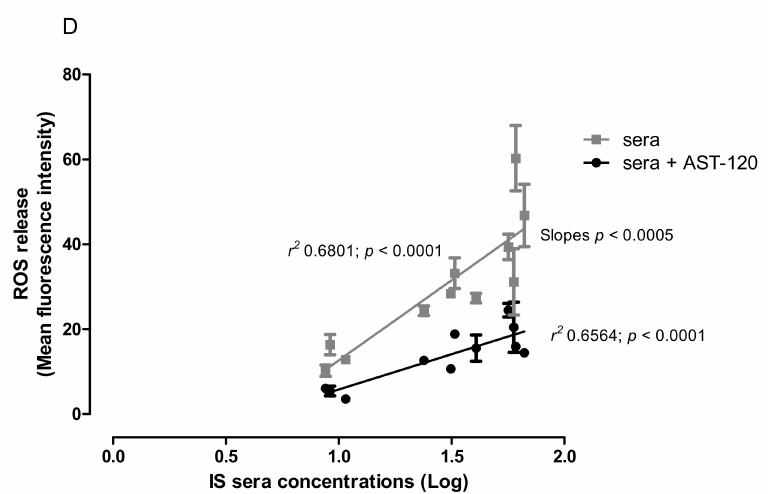
Figure 7. E ff ect on ROS formation of sera from eleven subjects: sera from three human healthy people (H1, H2, H3; Panel A ), sera from four CKD patients (CKD1, CKD2, CKD3, CKD4; Panel B ) and sera from four CKD dialysed patients (HD1, HD2, HD3, HD4; Panel C ), alone or in the presence of AST-120 in IEC-6 cells ( n = 15). Linear regression of ROS release by IEC-6 cells treated with sera alone or treated with AST-120 (Panel D ; n = 3 measurement of each sample). Resulted indicated F = 10.9369, DFn = 1, DFd = 40, p < 0.0001 and the di ff erence between the slopes are considered very significant (Panel D ). Values are expressed as mean fluorescence intensity. ◦◦◦ , ◦◦ , ◦ denote p < 0.001, p < 0.01 and p < 0.05 vs. control. ###, ##, # denote p < 0.001, p < 0.01 and p < 0.05 vs. serum